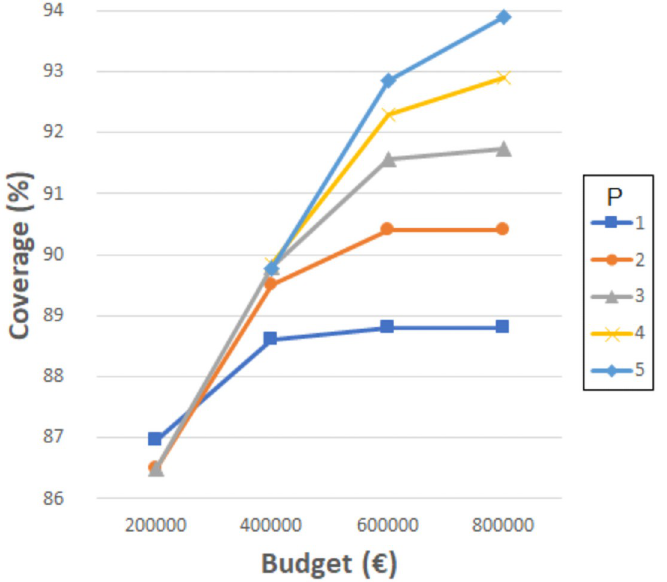
Fig 15. Coverage in 2025-2030 with new schools.